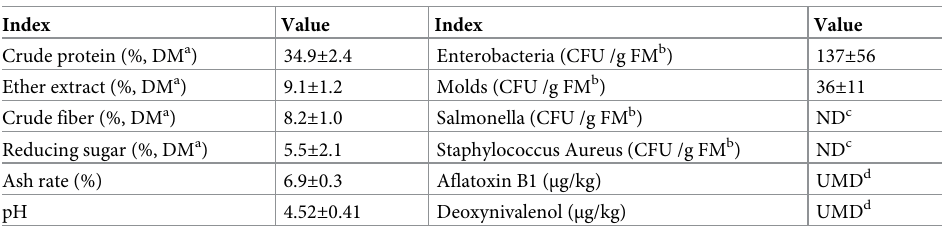
Table 1. The characteristics of the raw